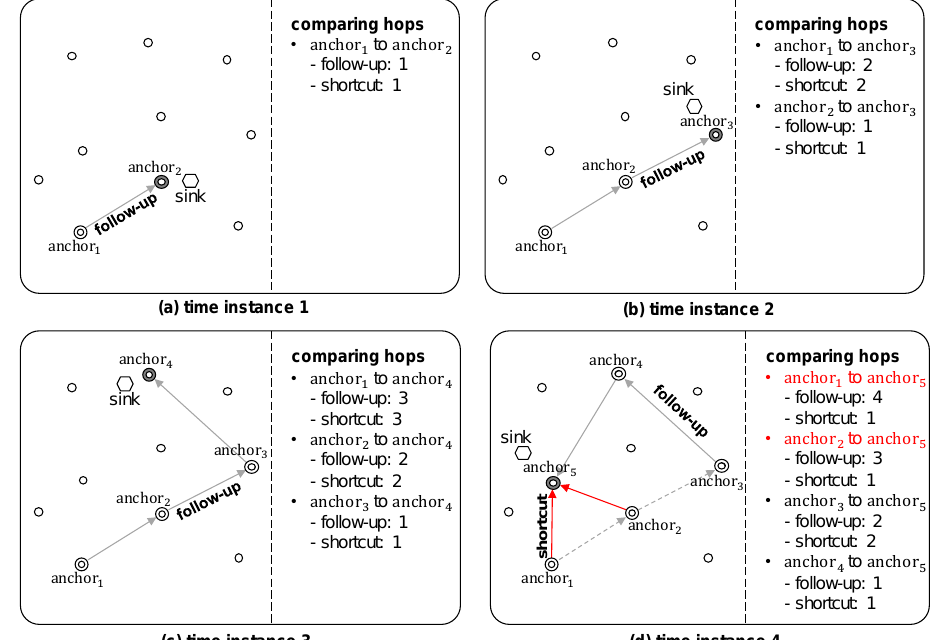
Figure 11. Shortcut